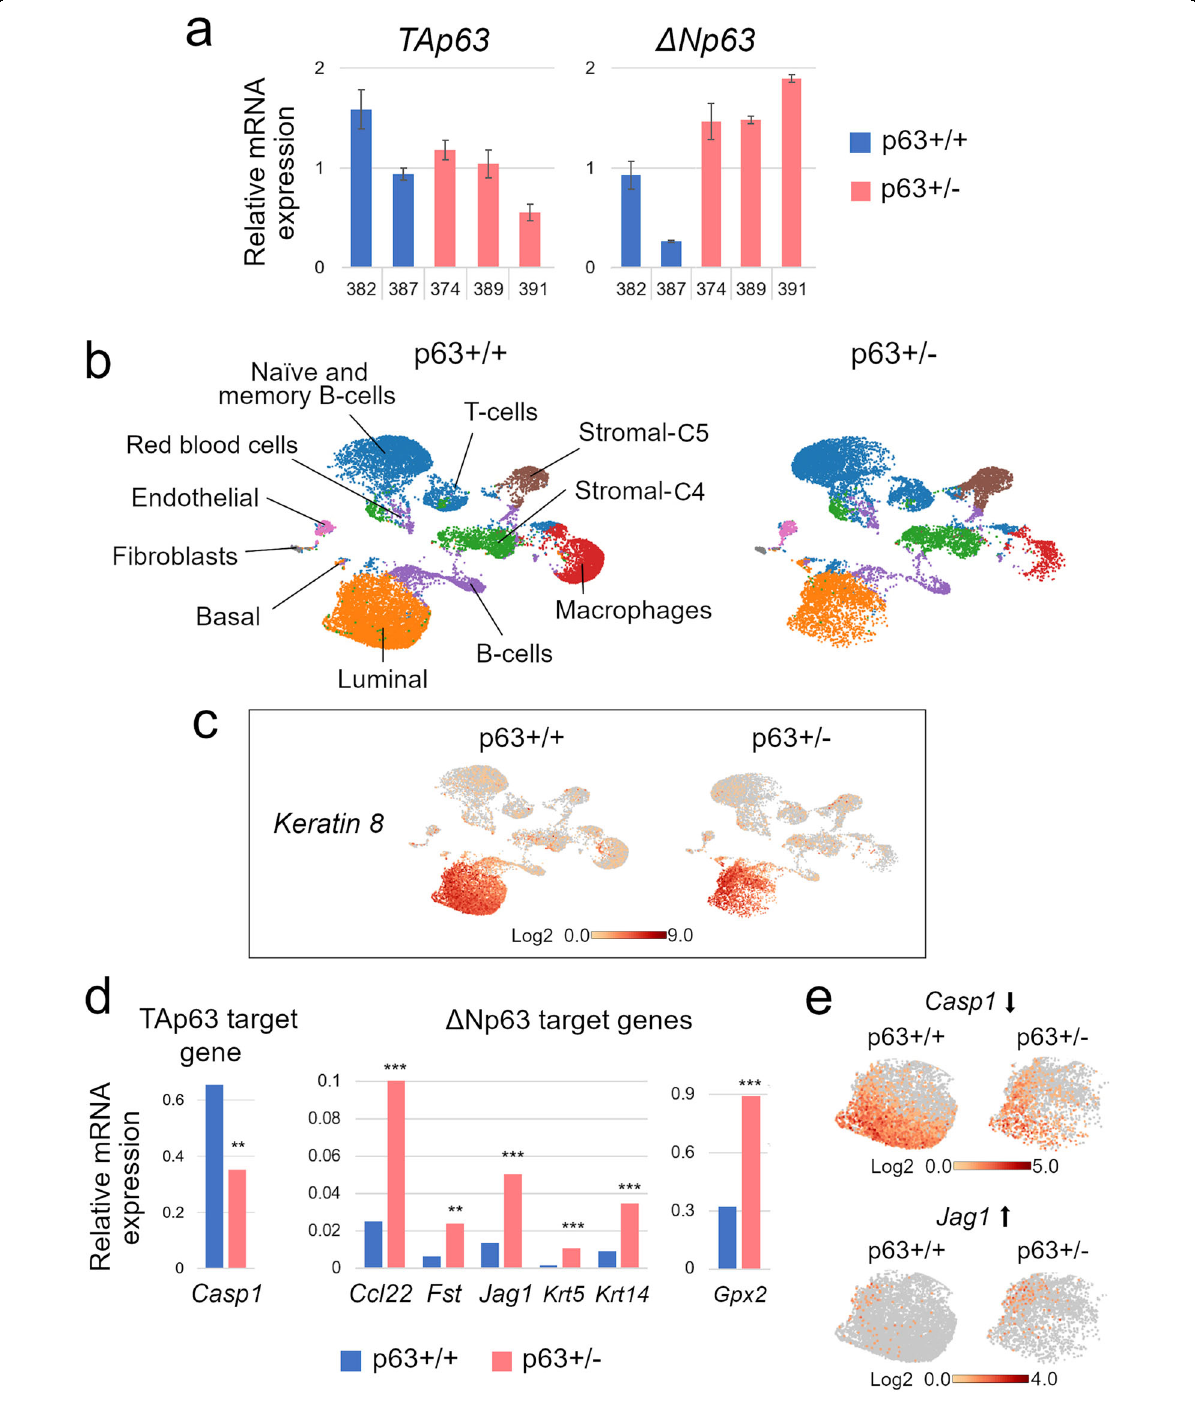
Fig. 3 Downregulation of TAp63 and upregulation of Δ Np63 isoforms in p63 + / − luminal cells. a Quantitative RT-PCR on independent p63 + / + ( n = 2) and p63 + / − ( n = 3) CD24 high (i.e., luminal) FACS-sorted cells. b – e ScRNA-seq analysis of pooled p63 + / + ( n = 4) and p63 + / − ( n = 3) CD24 pos (i.e., mammary epithelial) cells. b UMAP plots visualized in Loupe browser, see Supplementary Table 2 for details. c Krt8 marks luminal cells. d , e Average expression ( d ) and representative UMAP plots ( e ) of signi fi cantly altered TAp63 and Δ Np63 target genes in the luminal cluster of p63 + / + and p63 + / − mammary epithelial cells, ** p < 0.01, *** p <